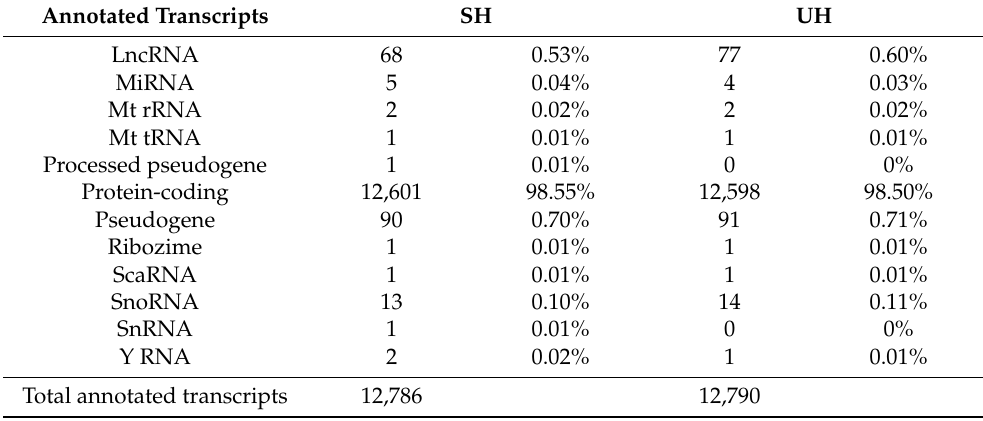
Table 1. Characterization of the transcripts identified in the inguinal and umbilical ring samples.